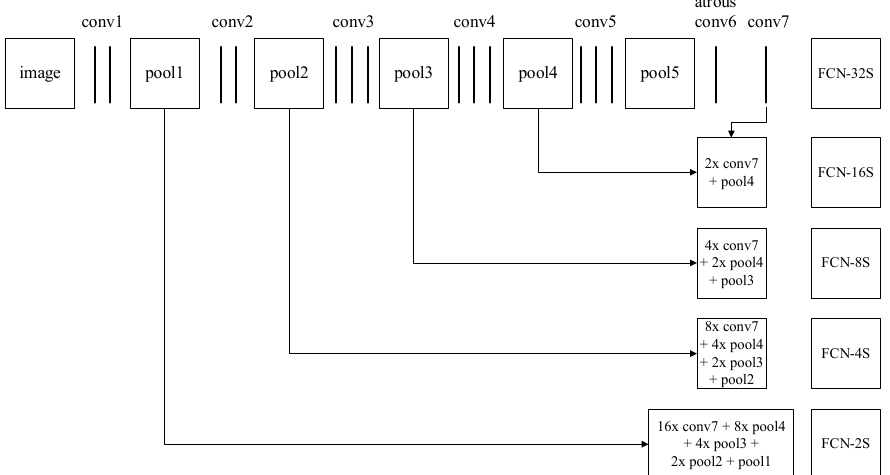
Figure 3. Multiscale feature fusion. We first change the VGG-based FCN’s convolution six layer, which has the highest parameter calculation quantity, to atrous convolution with a kernel size of 3 × 3. The atrous convolution can increase the receptive fields without reducing the spatial dimension while simultaneously decreasing the computational complexity and inference time. Then, based on the FCN-8s, we use the skip architecture to fuse the shallow detail features in the neural network and train the FCN-atrous-2s model on the homemade dataset.